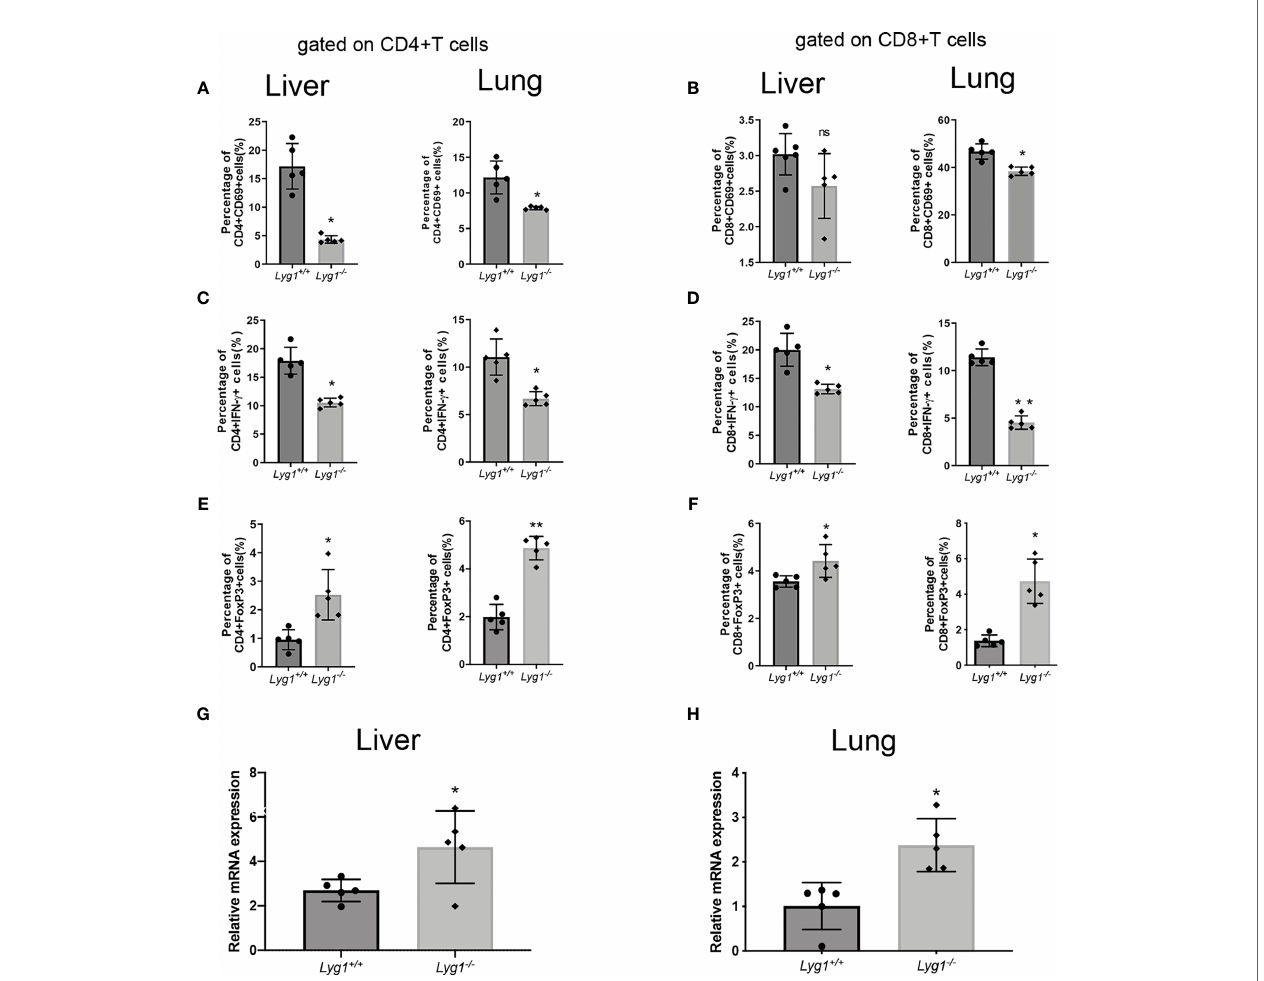
FIGURE 5 | LYG1 de fi ciency inhibited allogeneic T cells function in livers and lungs. Lymphocytes were isolated from livers and lungs of recipient mice on day 7 after transplantation and analyzed by fl ow cytometry and qPCR. (A, B) The percentages of CD69 expression in CD4 + T cells and CD8 + T cells. (C, D) The percentages of IFN- g expression in CD4 + T cells and CD8 + T cells. (E, F) The percentages of Treg in CD4 + T cells and CD8 + T cells. The percentages of Figure 5 (A – F) were all gated on H2Kb+CD4+ cells or H2Kb+CD8+ cells in lymphocytes isolated from livers and lungs. (G, H) Foxp3 expression of lymphocytes isolated from livers and lungs were examined by qPCR. Independent experiment was performed 3 times. The results in the repeats were similar. n=5 per group. Statistical results are expressed as the mean ± SD, *p < 0.05 and **P < 0.01 compared with Lyg1 +/+ group. ns, no signi